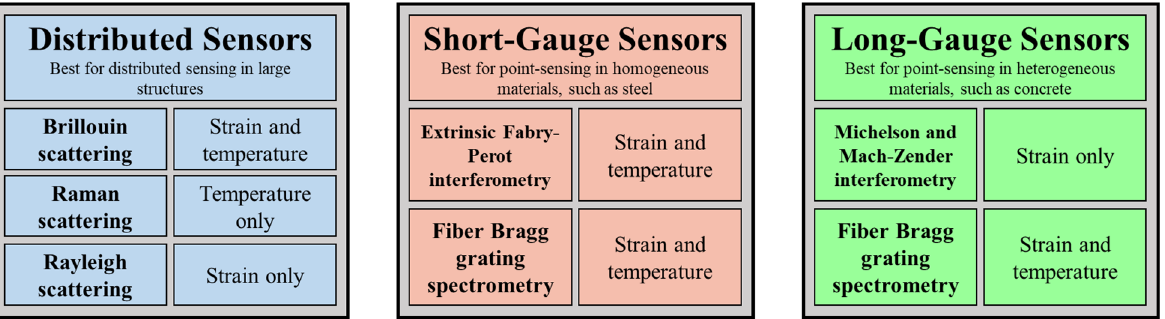
Figure 8. Schematic diagram of classification of FO sensor based on application type.